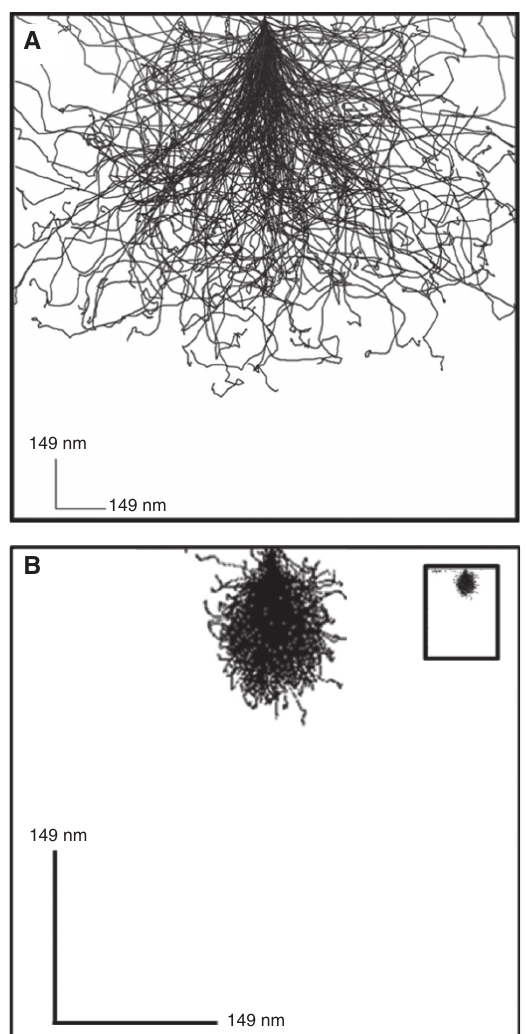
Figure 2 Comparison of the interaction volume of an electron and a helium ion interaction with a carbon surface. (A) Simulation of the interaction volume generated by a 10-kV electron beam bombarding a carbon surface generated by the Win-X-ray program (http://montecarlomodeling.mcgill.ca/software/winxray/fea- tures.html); the scattering image includes backscattering electrons. (B) Simulation of the interaction volume generated by a 10-kV helium ion beam bombarding a carbon surface generated by SRIM